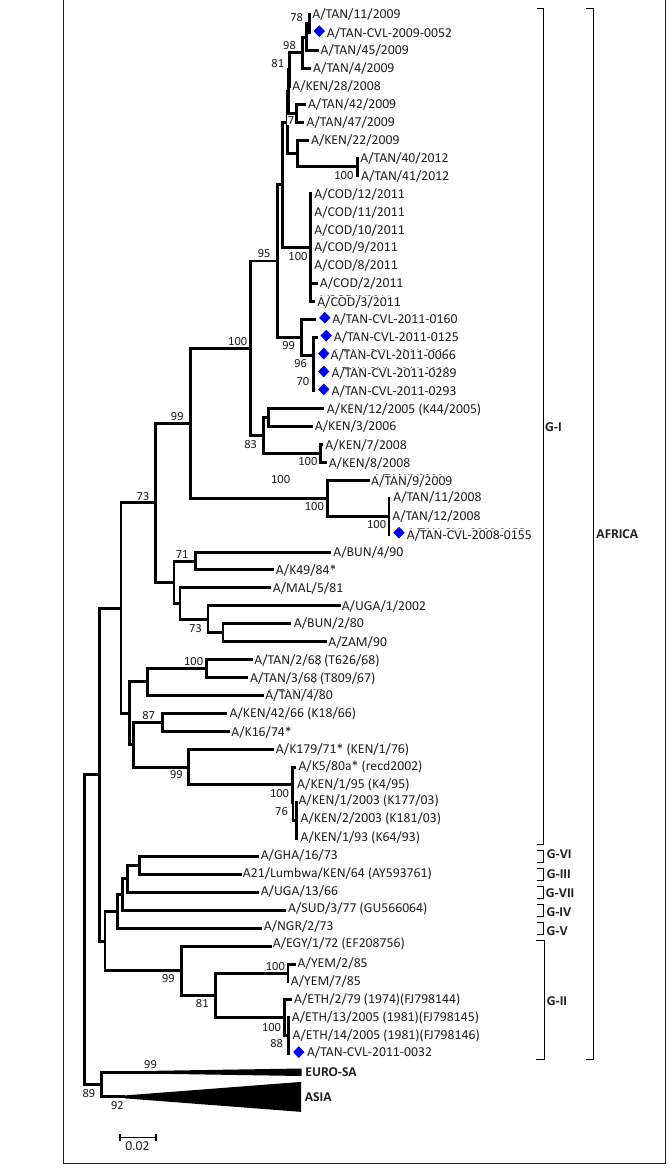
FIGURE 1: Midpoint-rooted neighbour-joining tree (based on the complete virus protein 1 coding sequence) showing the relationships between the foot- and-mouth disease virus serotype O isolates from Tanzania (see red coloured diamonds) and other contemporary and reference viruses.